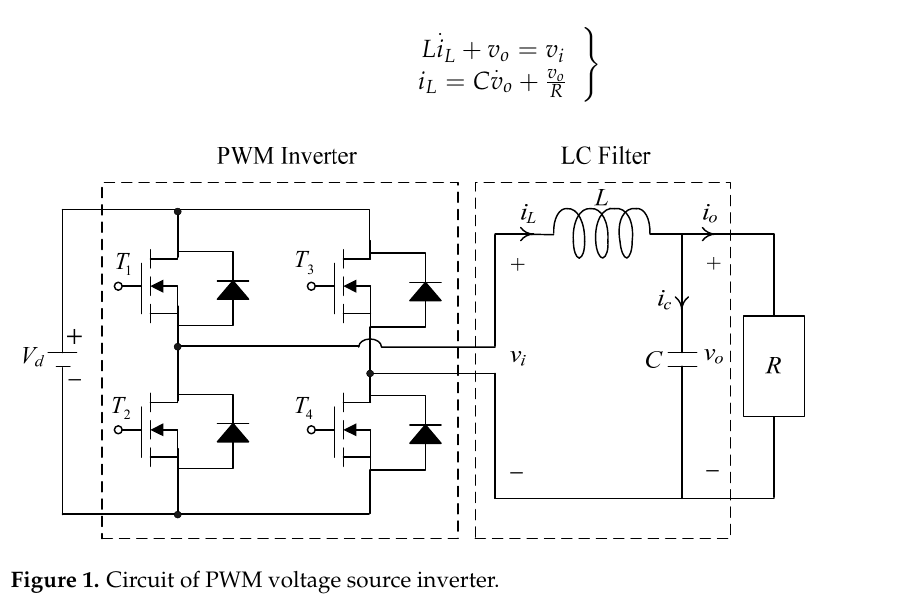
Figure 1. Circuit of PWM voltage source inverter.